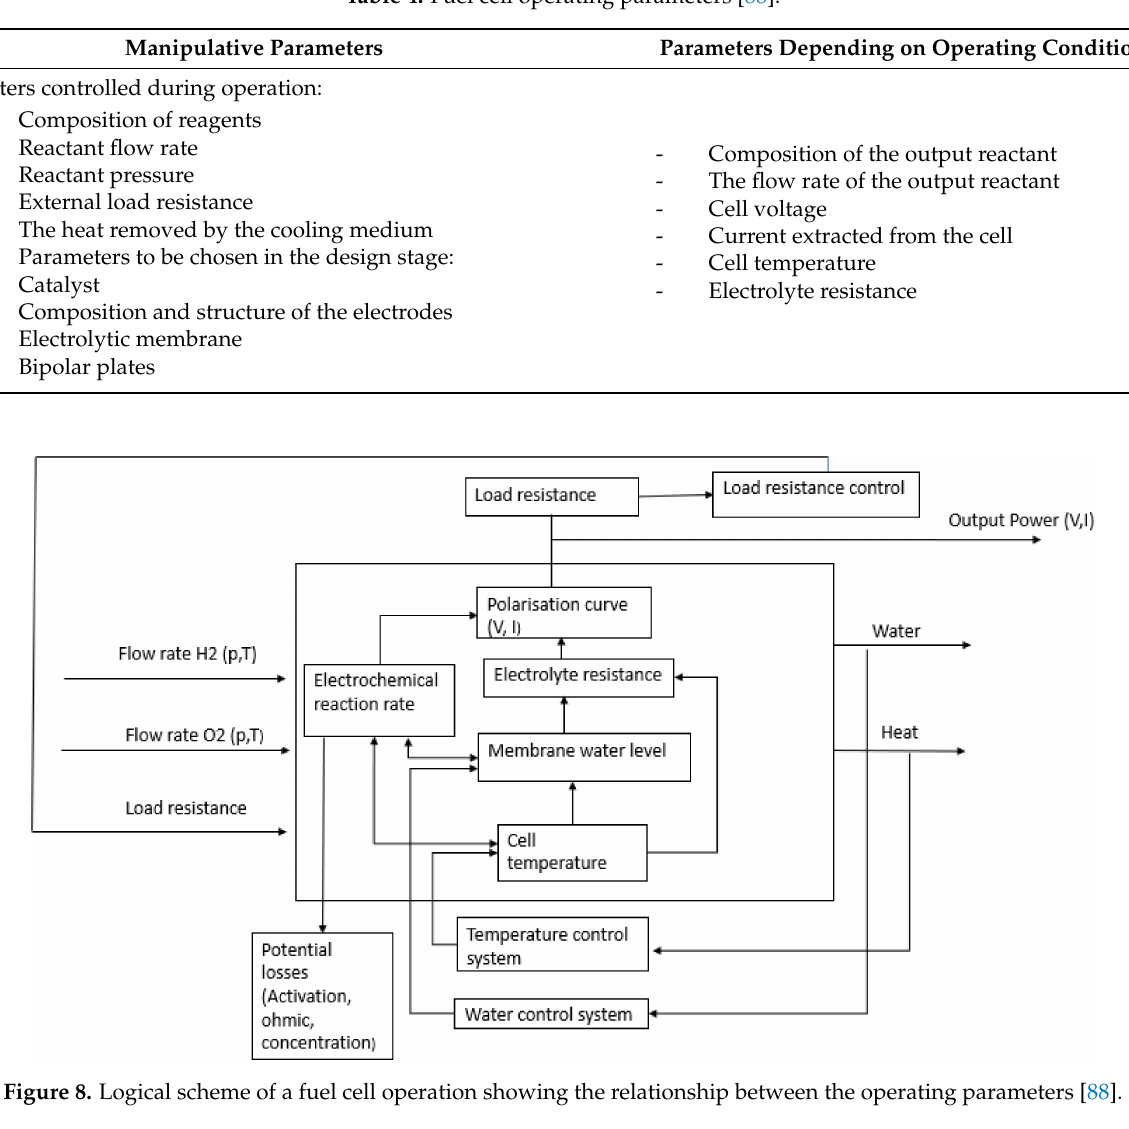
Table 4. Fuel cell operating parameters [88].